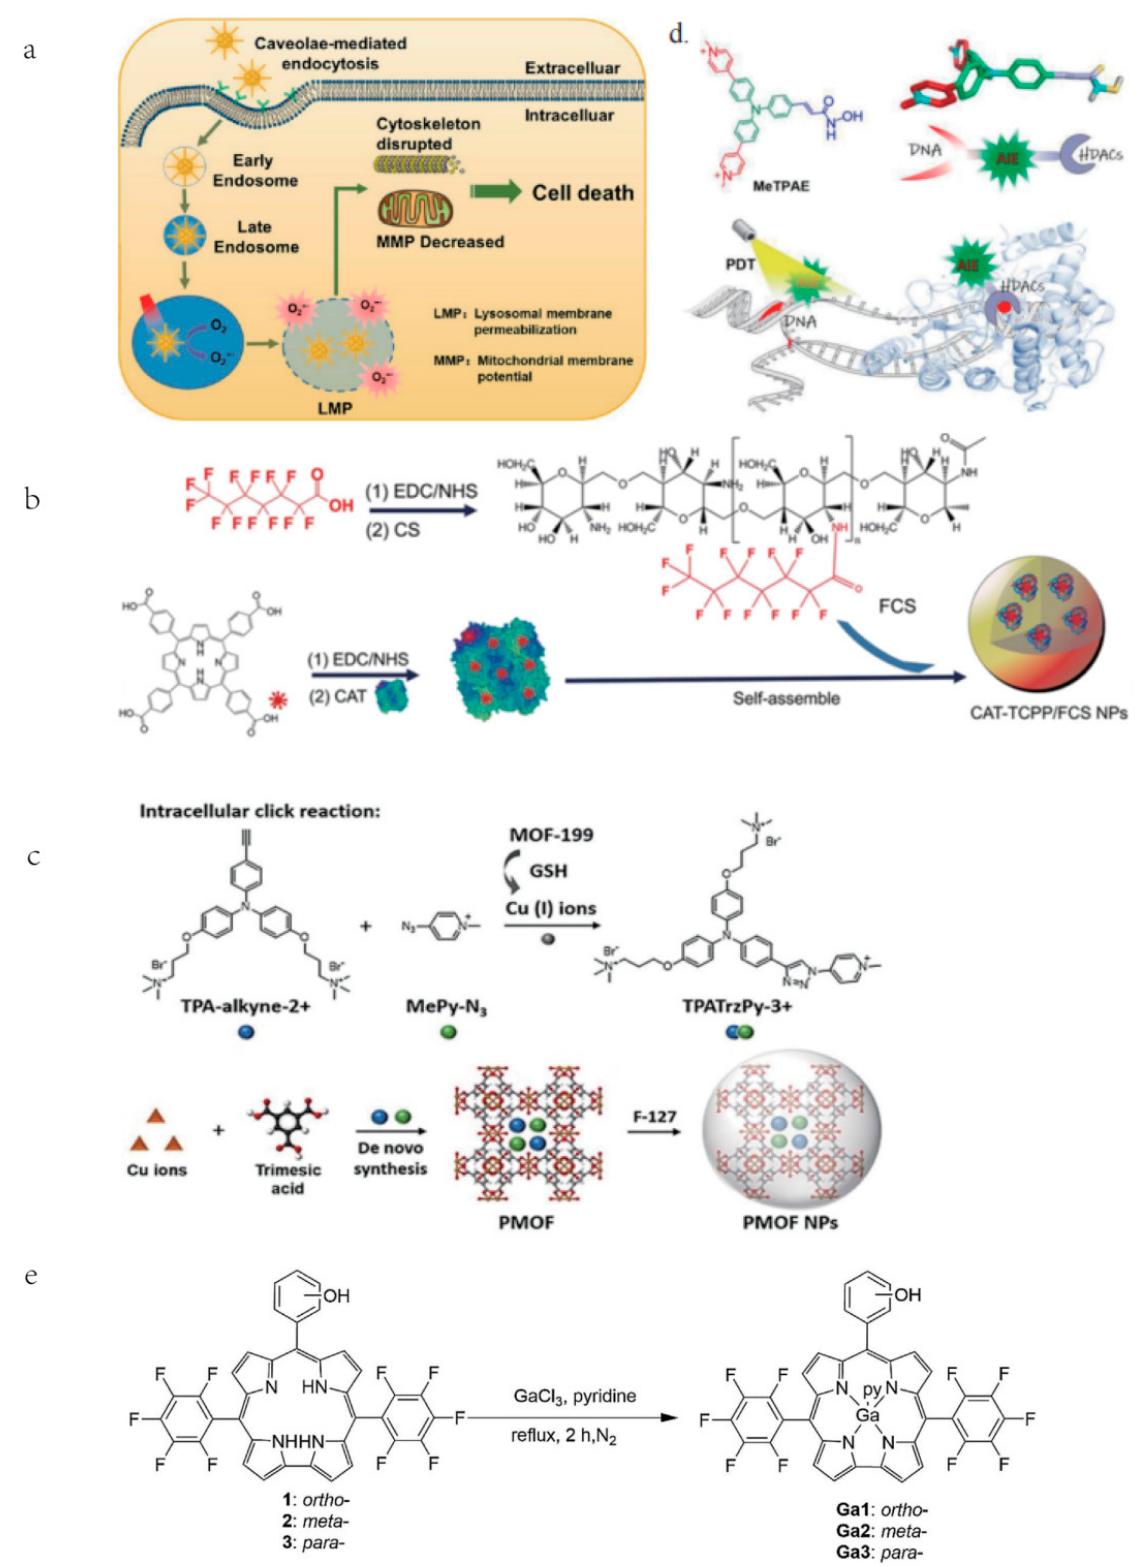
Figure 2. Different modifications and synthesis of different photosensitizers. ( a ) AuNC@DHLA can be internalized by endocytosis mediated by the lumen and accumulates in lysosomes, where LMP is produced as a result of ROS. Cell death eventually results from subsequent changes in MMP, mitochondrial morphology, and cytoskeleton disruption. Reproduced with permission from Ref.